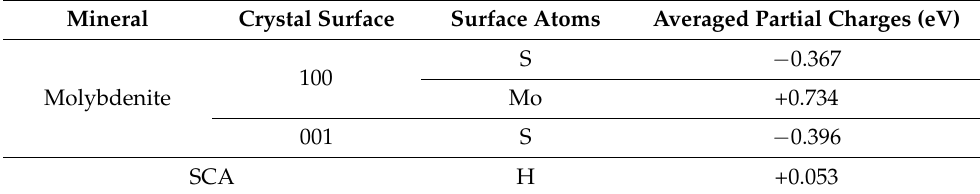
Table 1. The averaged partial charges of SCA/MS001/MS100.